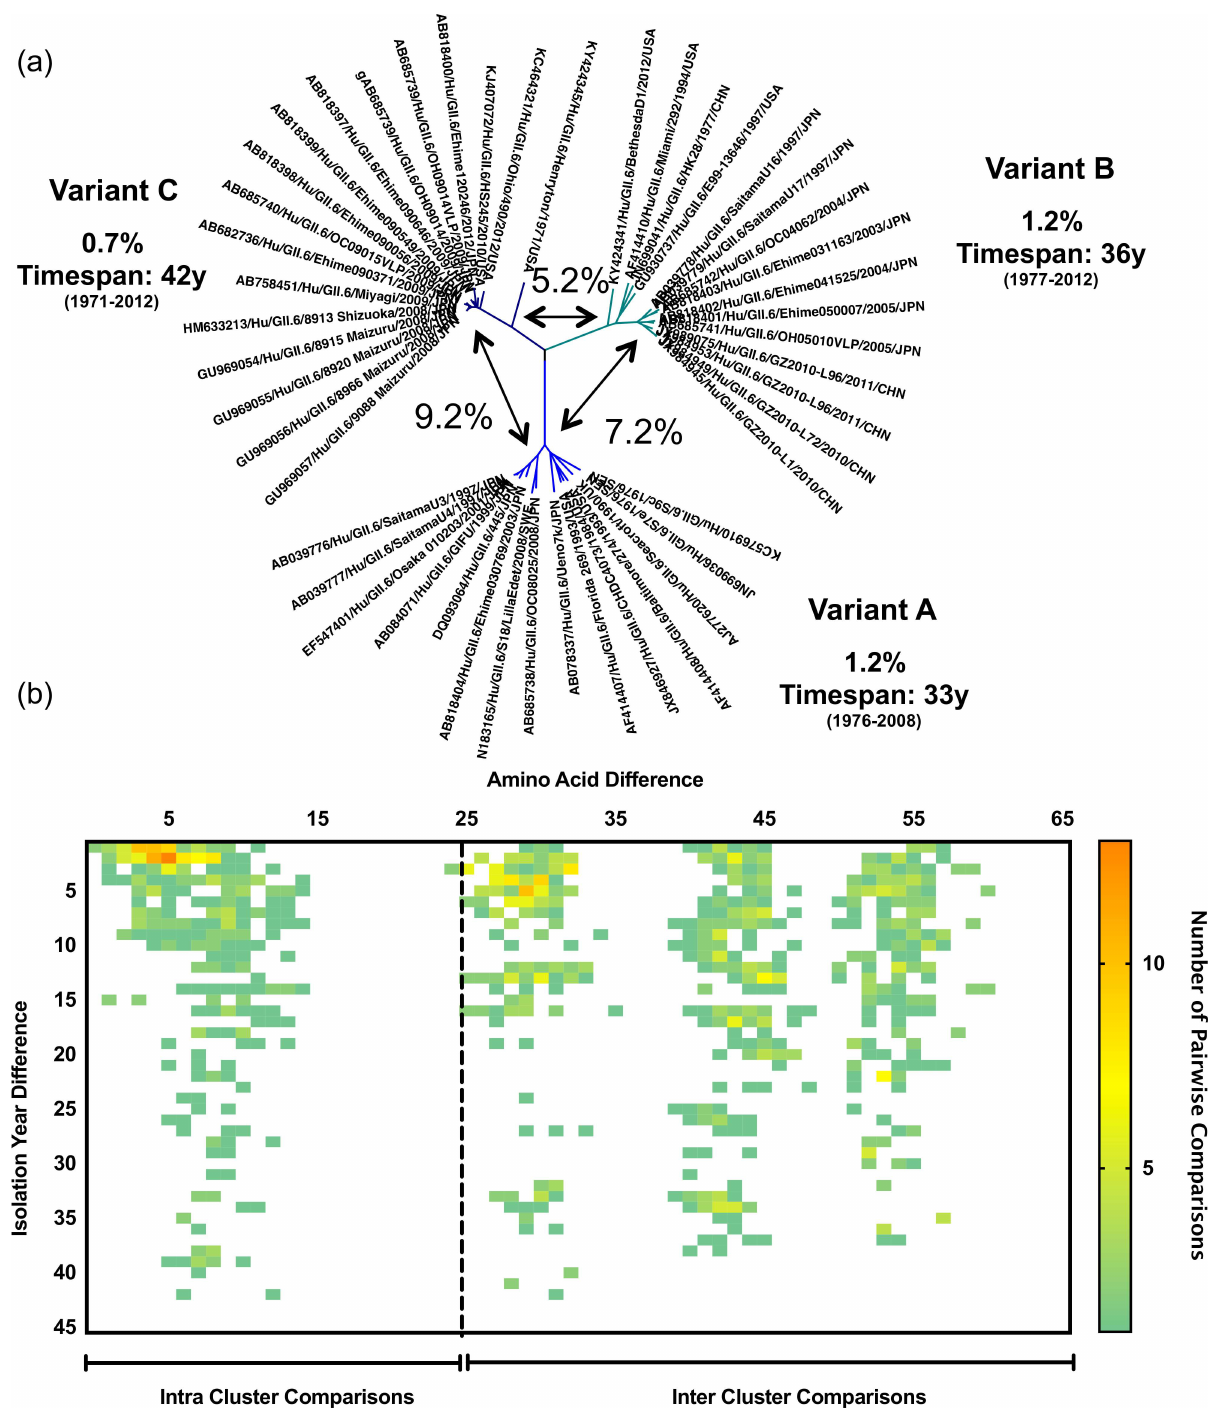
Fig 2. Diversity and evolutionary pattern of GII.6 viruses. (a) Phylogenetictree showingthe presenceof three variants (A-C) within the GII.6 genotype.Each variant branchis identifiedby different shades of blue. The timespanof isolationof the oldest and newest strain and the percent amino acid difference within each variant is shown. Arrows betweenbranchesrepresent the percent amino acid difference betweenvariants. Tree was constructed using nt sequencesencodingthe VP1 and Kimura-2 parameter and Neighbor-Joiningmethod as implemented in MEGA v6. (b) Diversity plot showing the presence of discrete values representingdifferences within and betweenthe three GII.6 variants. The GII.6 genotypehas strains that differ by only a few aa ( < 10) but identified over 40 years apart, or strains can differ by almost 57 aa and detected in the same year. Heat map represents the number of pairwise comparisons, red being the highestand green the lowest numberof pairwisecomparisons. Similardata were generatedfor 14 other norovirusgenotypes. doi:10.1371/journal.ppat.1006136.g002 PLOS Pathogens| DOI:10.1371/journal.ppat.1006136 January19,